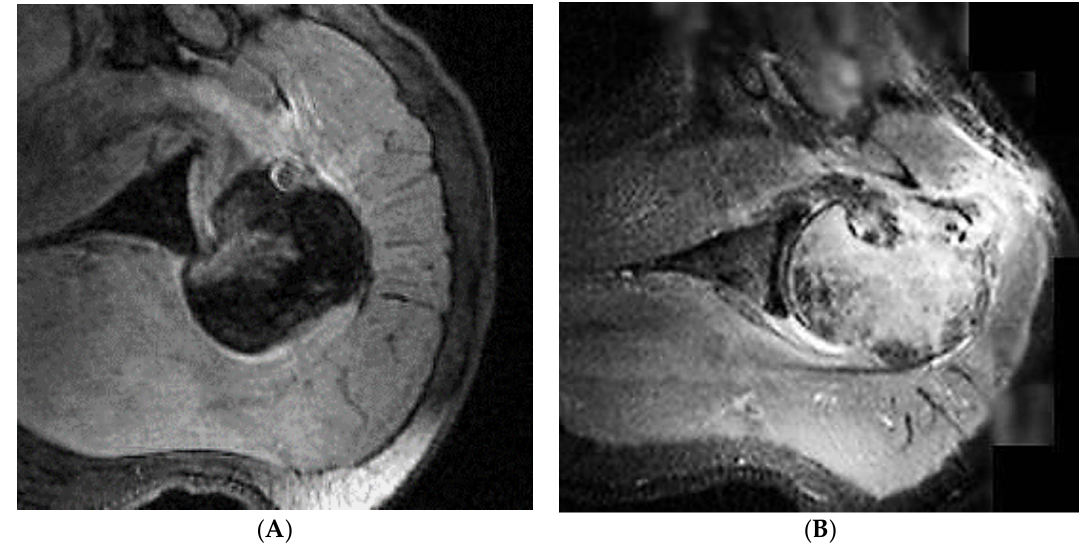
Figure 5. Patient 4: ( A ) Comparative evaluation through pre- and post-surgery MRI; ( B ) the filling defect of the humeral head is evident.